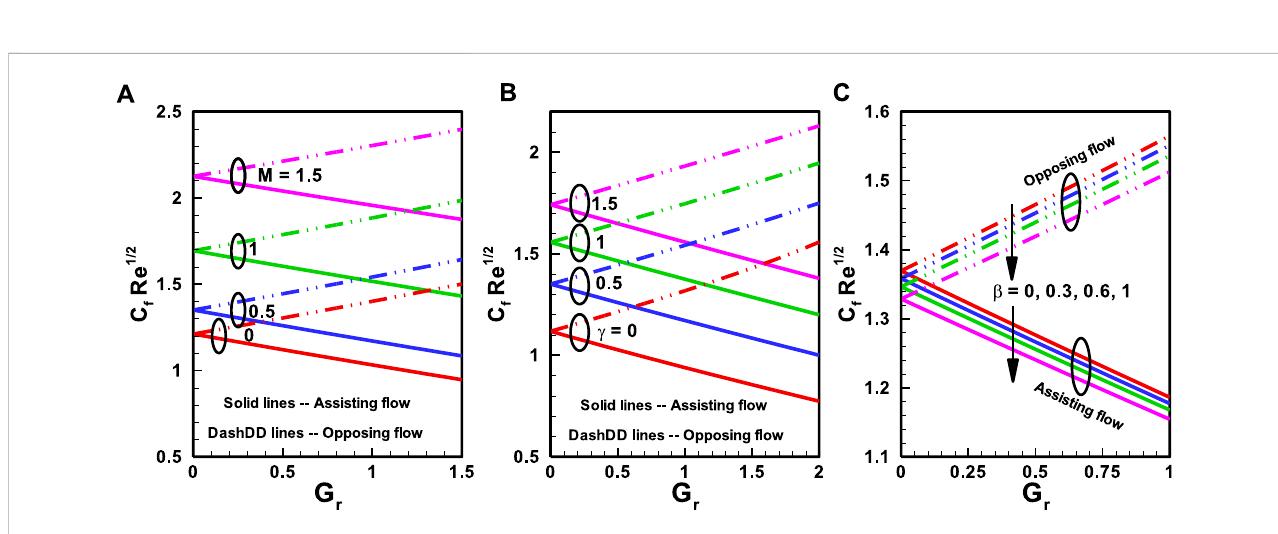
FIGURE 6 Variation of Coef fi cient for Skin friction (A) Hartmann number M , (B) Eyring-Powell fl uid parameter γ and (C) Eyring-Powell fl uid parameter β .